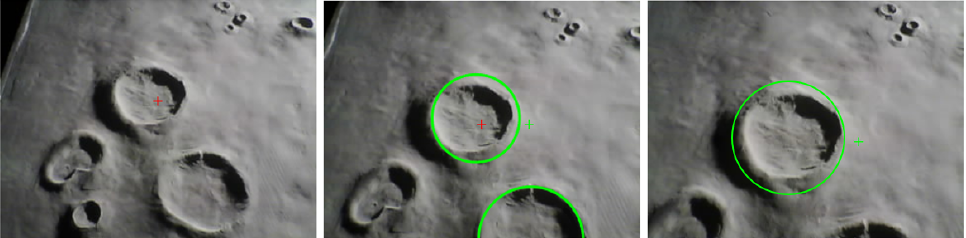
Figure 26. Hazard detection and avoidance procedure for the hardware simulation (images taken at t = 0 s, t = 20 s, and t = 40